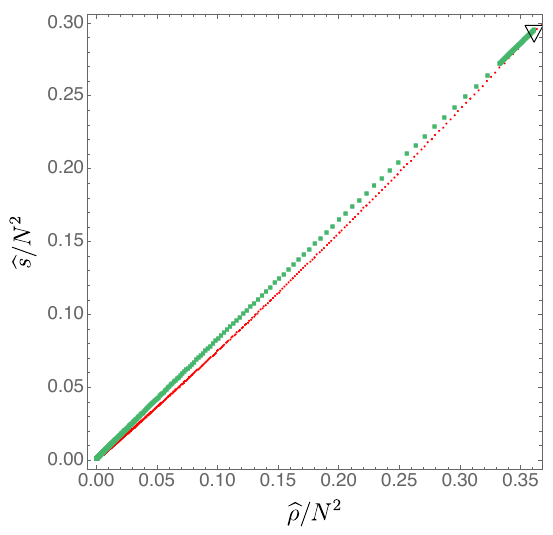
Figure 5 . The entropy density s=N 2 as a function of (cid:26)=N 2 : the green squares (upper branch) b b describes the family of solutions with a nontrivial gaugino condensate, (cid:27) 6 = 0, while the red disks (lower branch) correspond to solutions with (cid:27) = 0. Note that the latter family was constructed in section 3.3.1 and the associated results presented here represent a zoom-in of (cid:12)gure 2 in the relevant region m (cid:20) m g where it coexists with the gaugino condensate solutions. b b